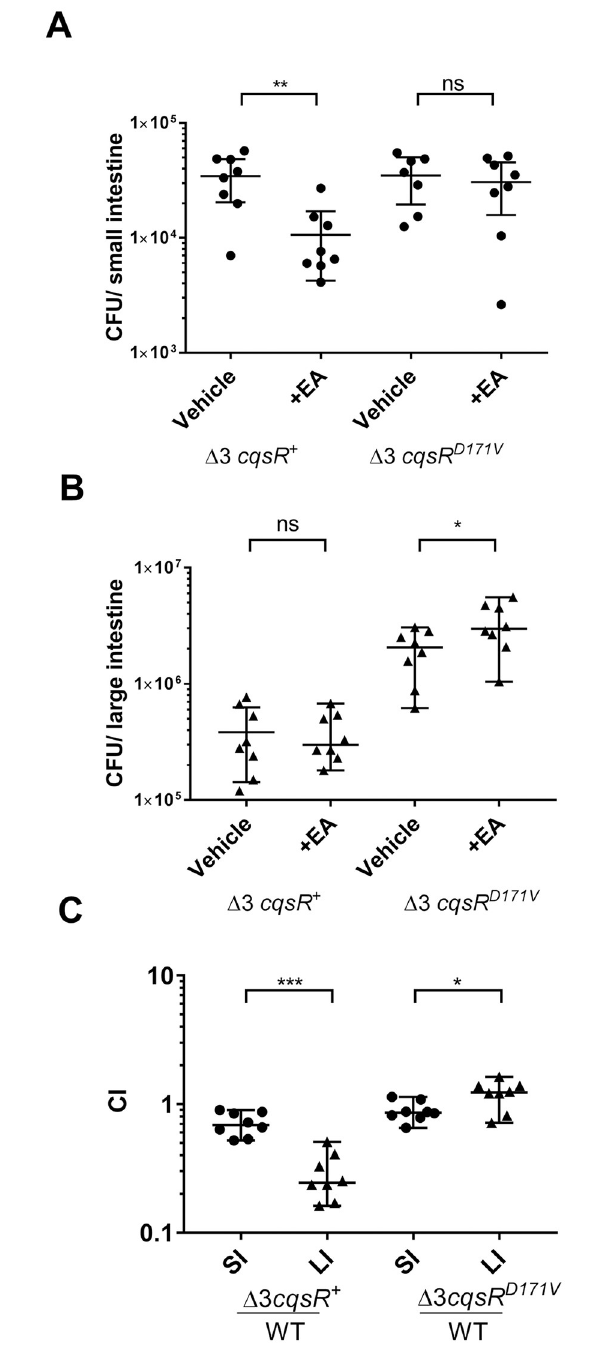
Fig 6. Effect of ethanolamine on CqsR quorum-sensing response inside animal hosts. CFU counts per A) small intestine homogenate or B) large intestine homogenate collected 8 hr post infection from mice (n = 8) singly infected with a Δ 3 cqsR + or Δ 3 cqsR D171V mutant strain. To assess the effect of ethanolamine on strain colonization, mice were gavaged with vehicle (LB) or 10mM ethanolamine (EA) at 2 and 4 hours post infection. C) Competitive indexes (CI) were determined between wild-type Δ lacZ and the indicated V . cholerae mutants in both the small intestine (SI) and large intestine (LI) of infant mice 24 hr post infection (n = 8). The Δ 3 cqsR + data presented in Fig 2 has been included for reference and comparison to Δ 3 cqsR D171V . Each symbol represents the CI in an individual mouse and data is represented with horizontal lines indicating the median with a 95% confidence interval for each group. � P < 0.05; �� P < 0.01; ��� P < 0.001 (unpaired t test). n.s. = not significant.